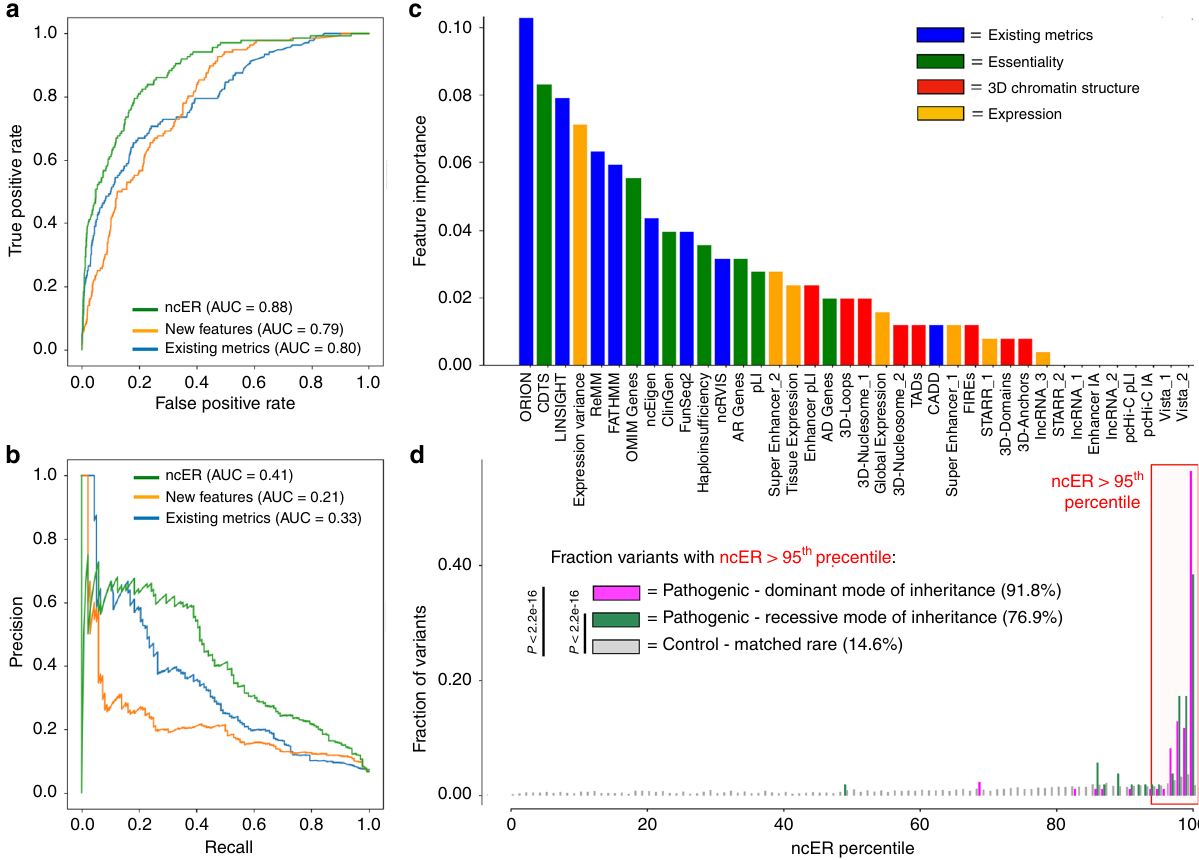
Fig. 1 Ensemble learning for the prediction of deleterious variants in the non-coding genome. Performance ROC-AUC ( a ) and PR-AUC ( b ) on the test set ( N = 136 non-coding pathogenic and N = 2017 control variants) of a model trained only with published deleteriousness metrics (blue), only with new features, namely essentiality, 3D genome organization and gene expression features (orange) and with both new features and published metrics (green, ncER). The importance of the various input features in the ncER model is shown in c . Blue, published scores; green, new essentiality features; red, new 3D chromatin structure features; orange, new regulatory/functional screen features. Panel d shows the distribution of ncER percentiles for an independent set of 137 curated non-coding pathogenic Mendelian variants compared to a set of singletons from gnomad matched by genomic element and distance to splice sites. There is statistically signi fi cant enrichment for both dominant ( N = 85) and recessive ( N = 52) non-coding pathogenic variants in high ncER percentiles. p Values were computed with Fisher's exact test. ROC receiver operating characteristic, PR precision-recall, AUC area under the Fig. 5C). To have an overview of the putative function of